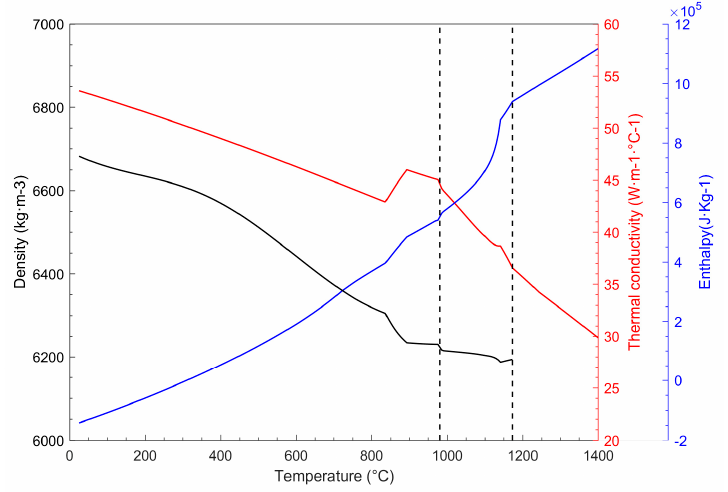
Figure 5. The curve of material properties over temperature.